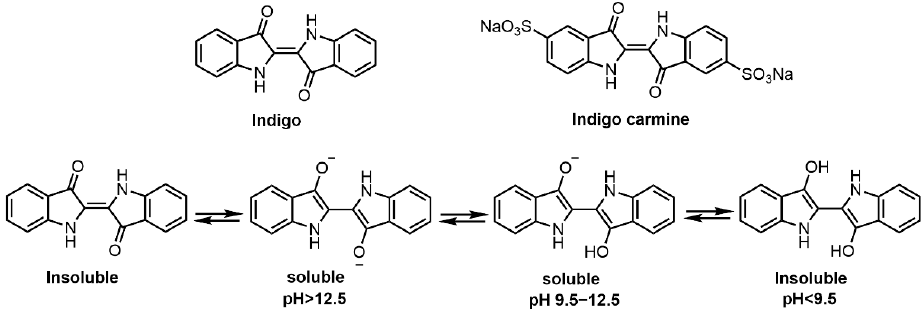
Figure 5. Molecular structures of indigo, indigo carmine and the pH effect on the soluble forms of indigos.